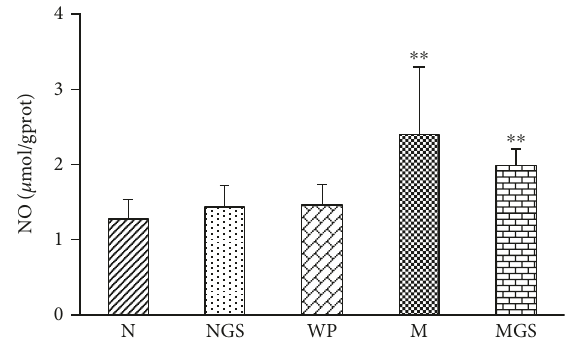
Figure 1: Brain nitrogen oxide (NO) levels of experimental animals. N: normal rats; NGS: normal rats fed by GS; WP: rats housed in wide platform; M: SD model rats; MGS: SD model rats fed by GS. Signi fi cant di ff erences were determined by one-way ANOVA. ∗∗ P < 0 01 versus the N